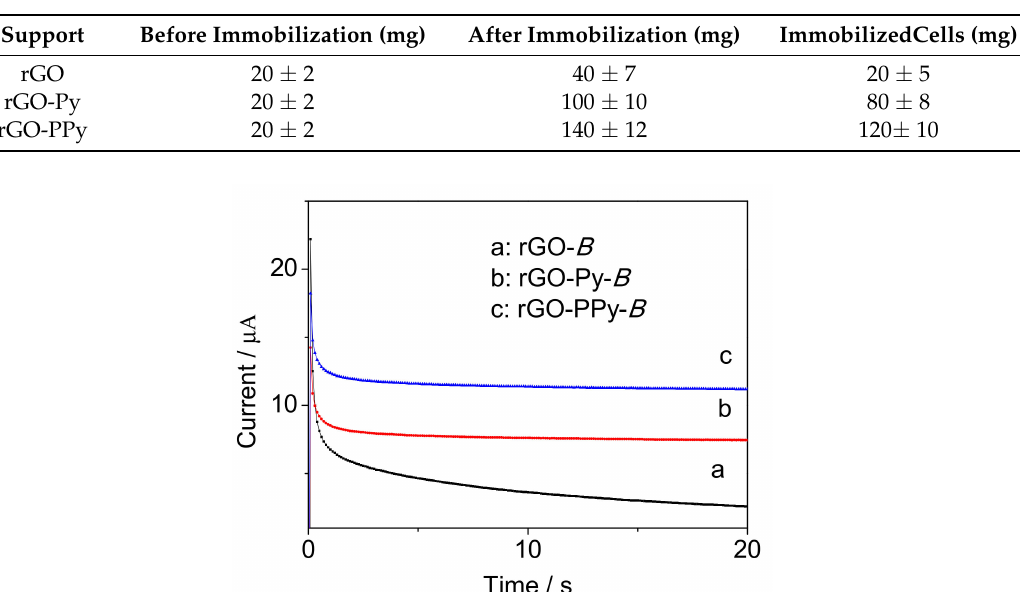
Table 1. Wet weight of different supports for B. subtilis immobilization.